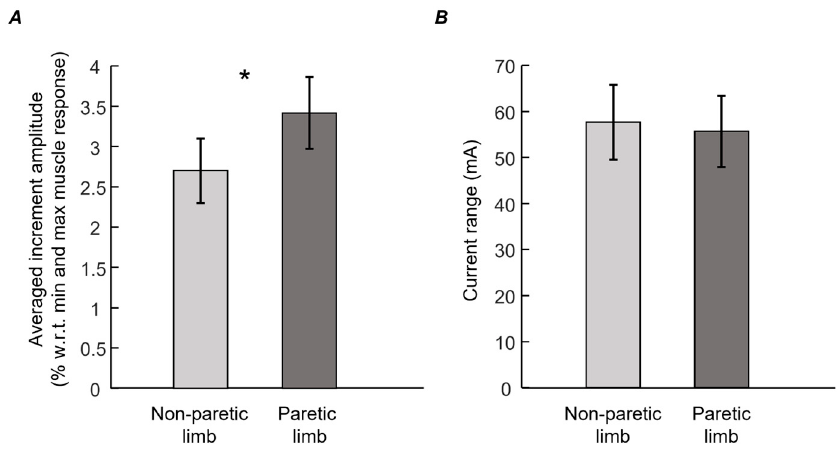
Figure 3. Boxplots in panels ( A , B ) show the increment amplitudes and current ranges calculated for non-paretic and paretic limbs of patients, respectively. The asterisk indicates a statistically significant difference ( p < 0.05) between limbs.